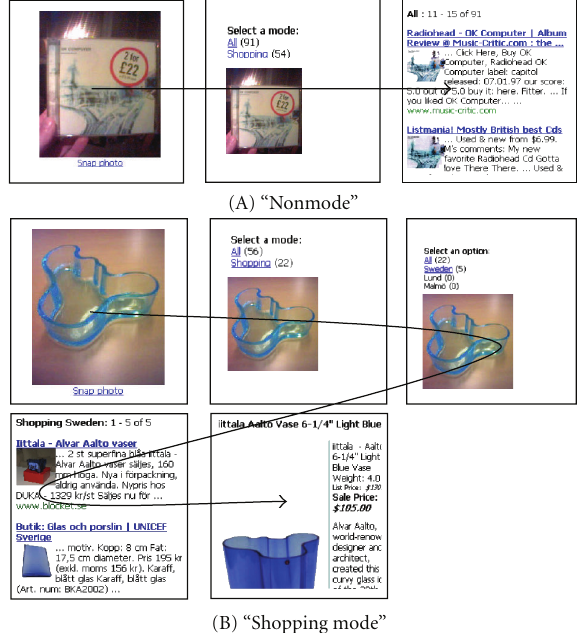
Figure 6: Screen shoots from the prototype used in the